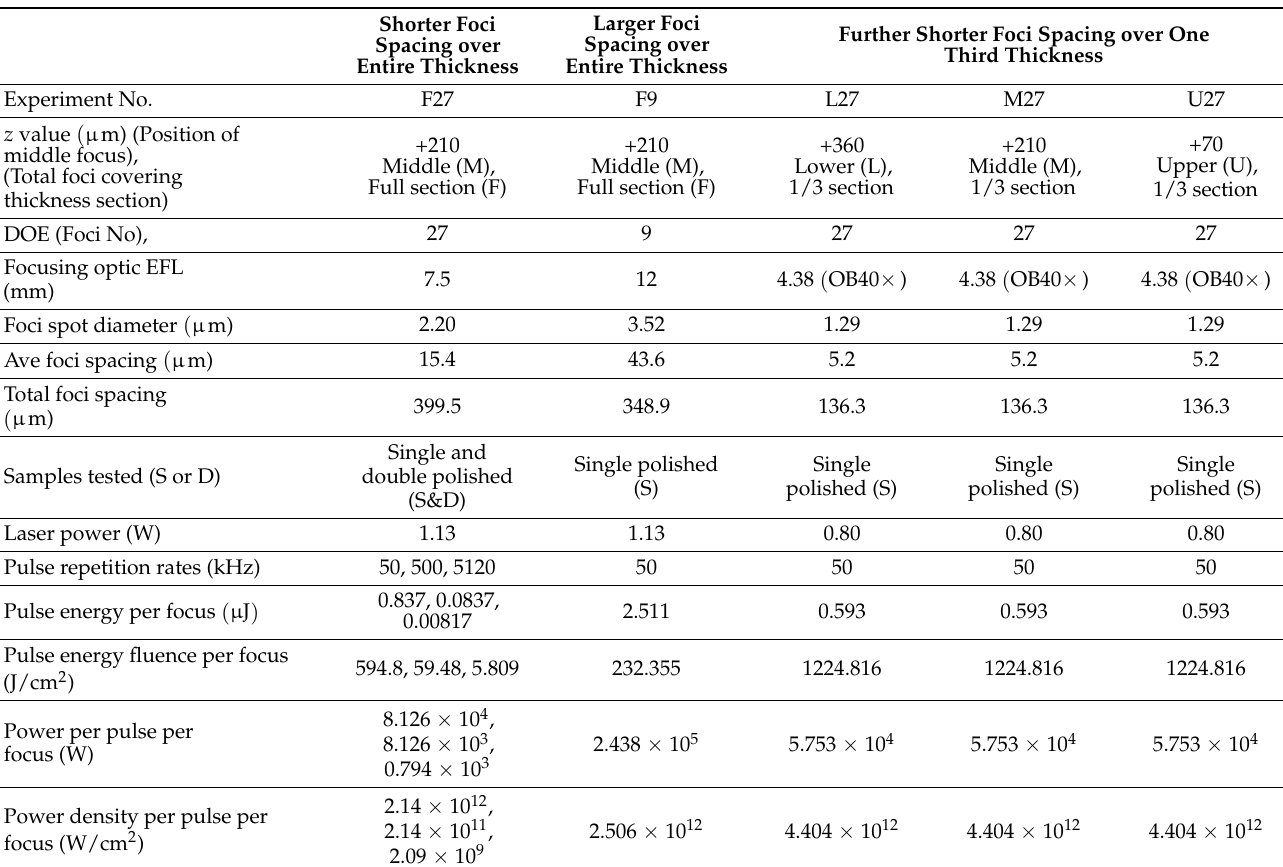
Table 1. Detailed optics combination for producing multi-foci and laser processing parameters. Larger Foci Shorter Foci Further Shorter Foci Spacing over One Spacing over Spacing over Third Entire Thickness Entire Thickness